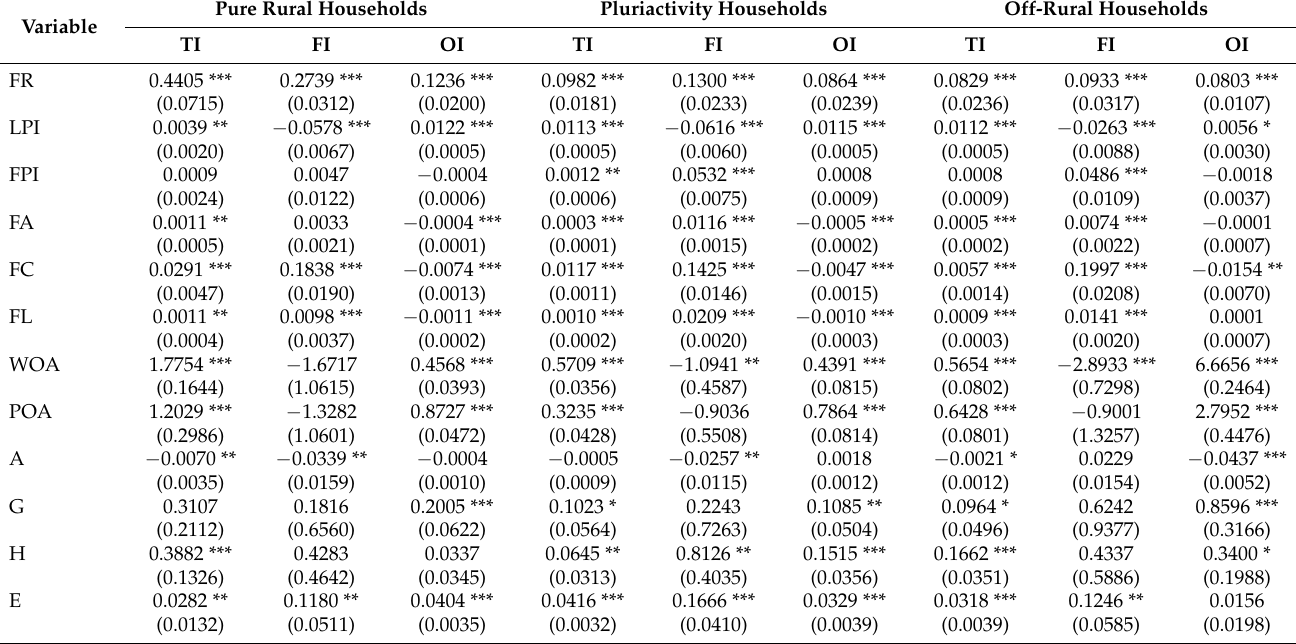
Table A4. Impact of collective forestland tenure reform on the income of farmers of different differen- tiation